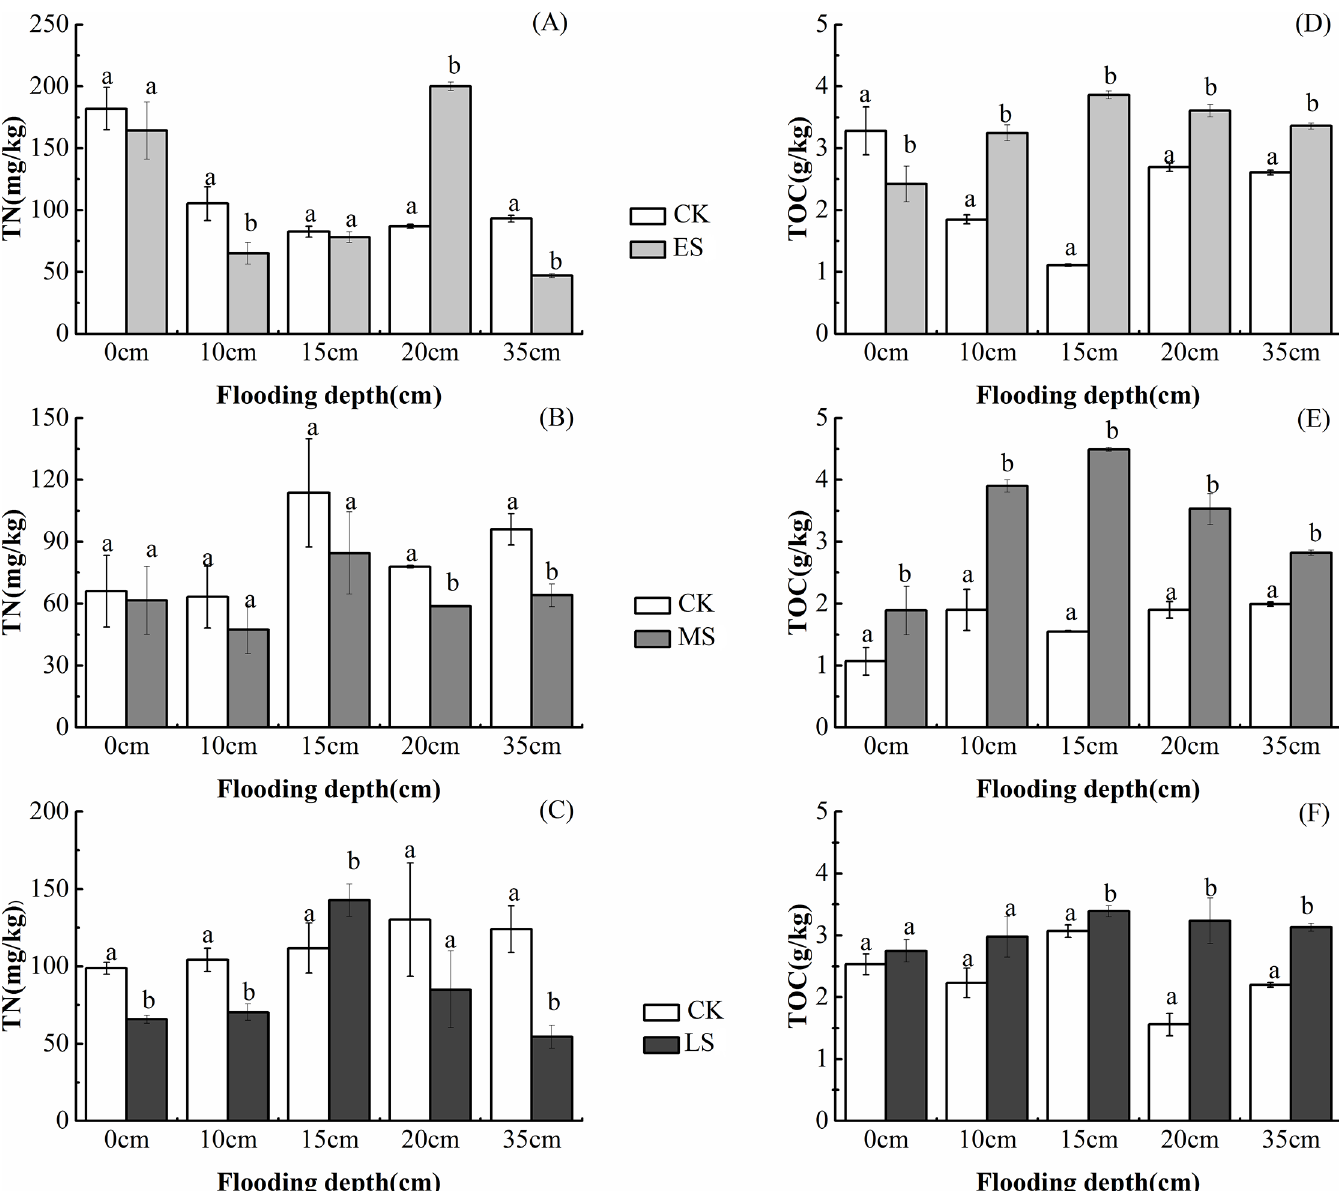
Fig 3. Total nitrogen(TN) and total organic carbon (TOC) subjectedto different water supplement regimes: A-C is total nitrogen at early stage, middle stage and later stage; D-F is total organiccarbon at early stage, middlestage and later stage. Different lower-caseletters indicateddifferences in TN and TOC.